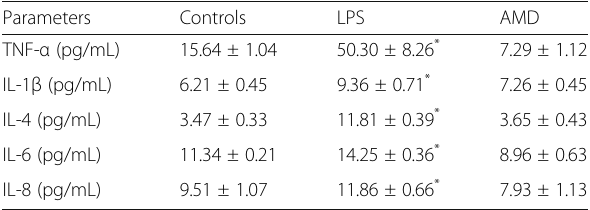
Table 1 Serum levels of cytokines in LPS- and AMD-treated